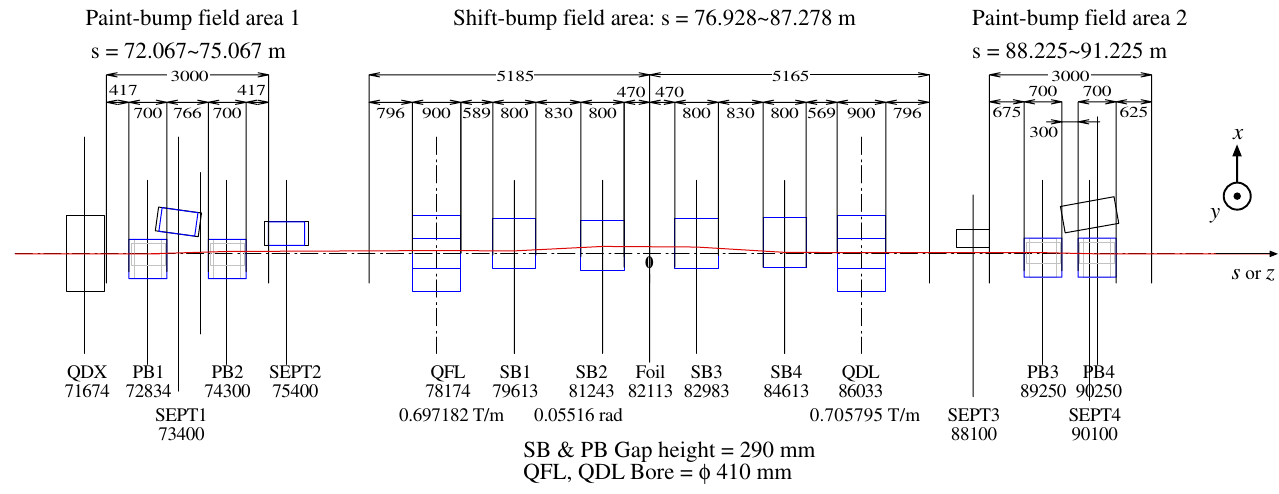
FIG. 1. (Color) Layout of the beam-injection line in the J-PARC RCS. The element positions and lengths are presented in [mm]. The s axis is along the designed beam orbit. In a straight section of the ring, the s and z axes are